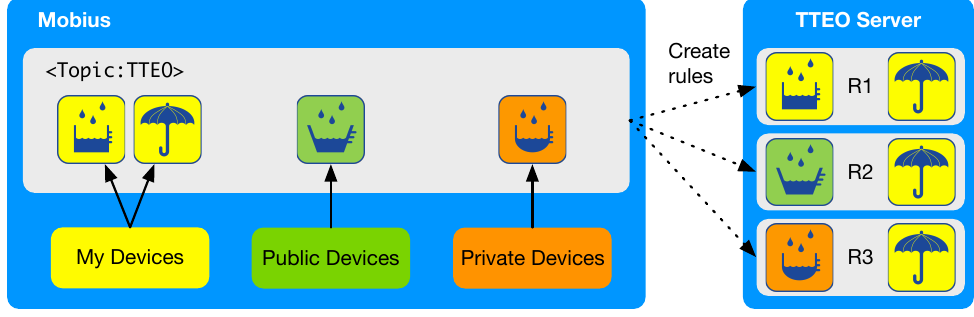
Figure 10. Create rules using my devices, public devices and private